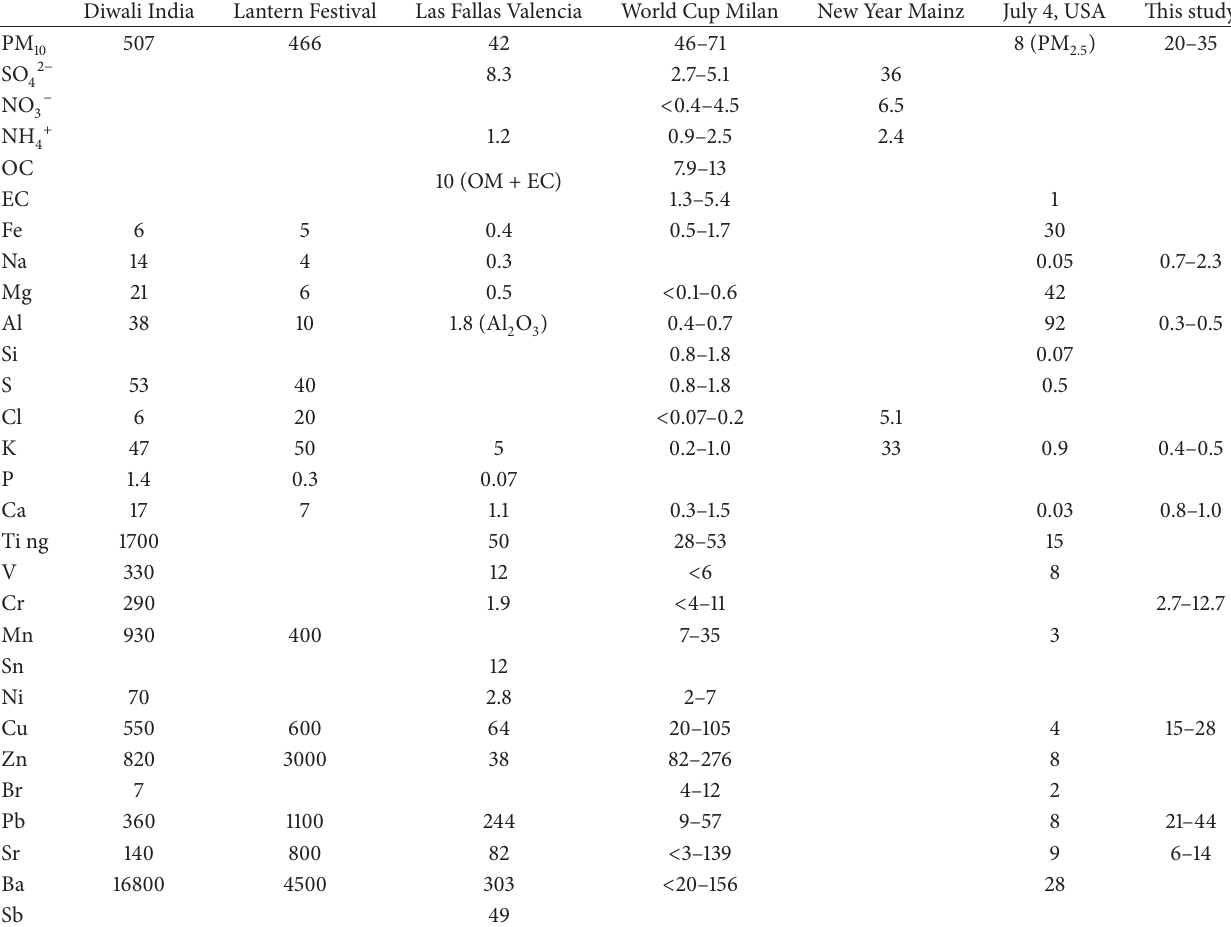
Table 2: Comparison of chemical components and elemental concentrations of particles during fireworks